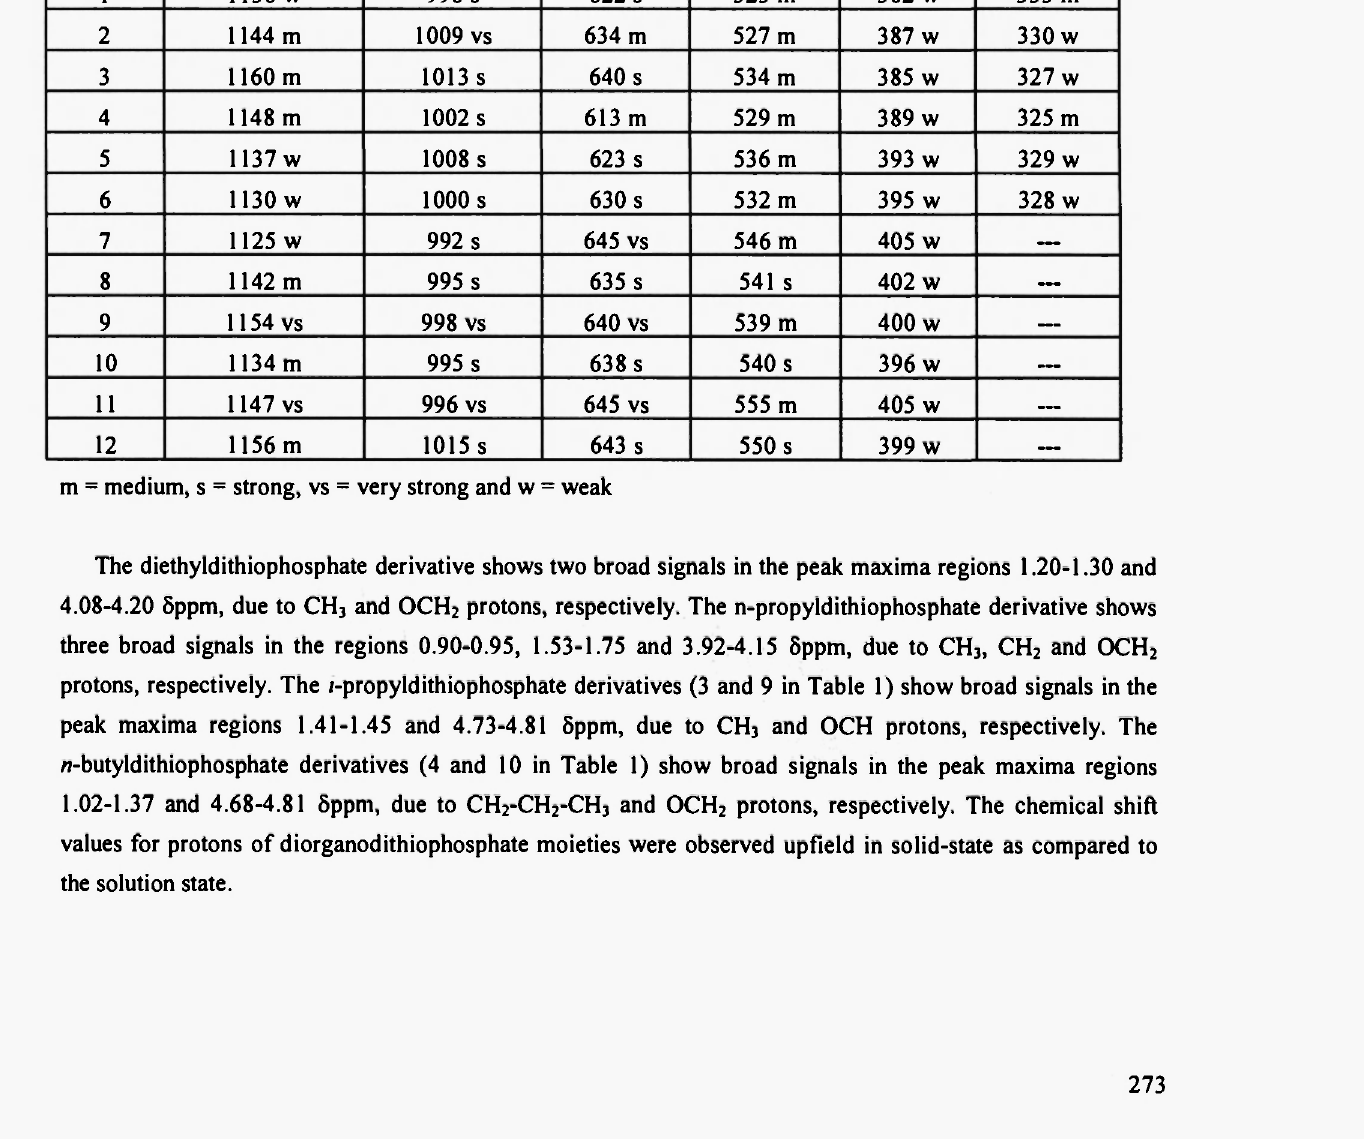
IR Spectral Data of l,3-dithia-2-stannacyclopentane diorganodithiophosphate